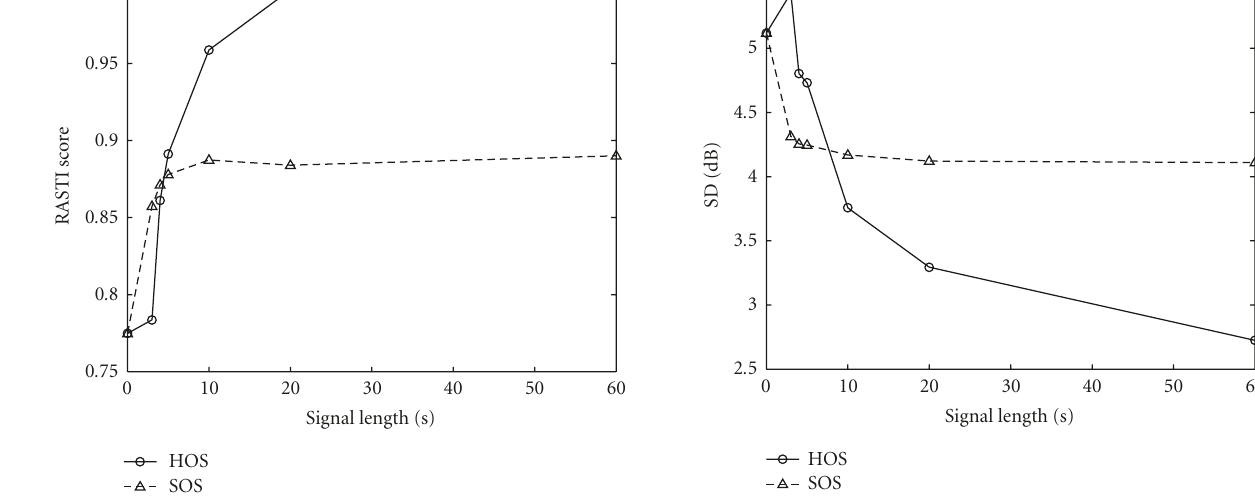
Figure 7: RASTI as a function of observed signal length. Figure 8: SD as a function of observed signal length.